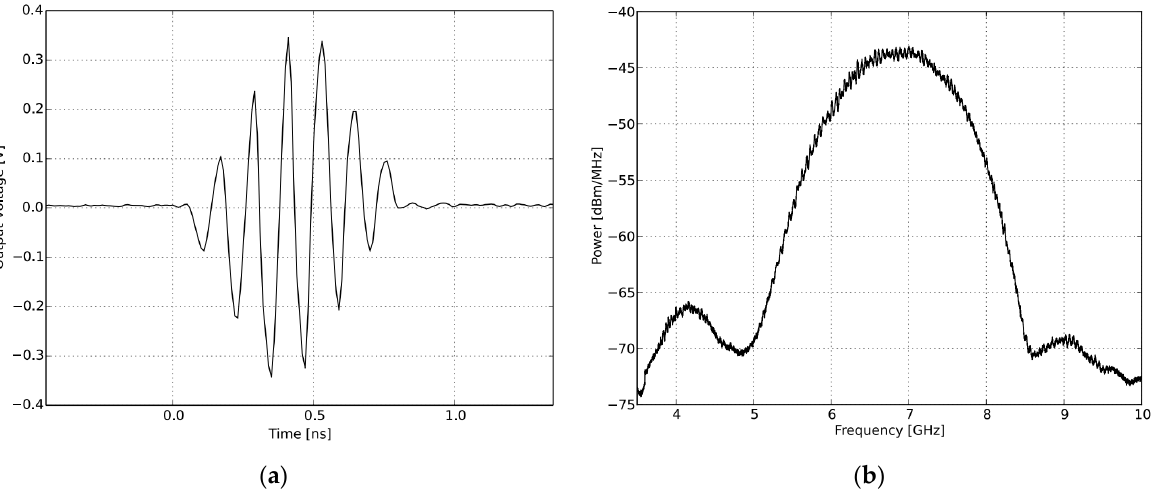
Figure 7. Time and frequency domain pulse shaped of IR-UWB radar for PGselect = 5; ( a ) Transmitted pulse shape in the time domain; ( b ) Transmitted impulse in the frequency domain.